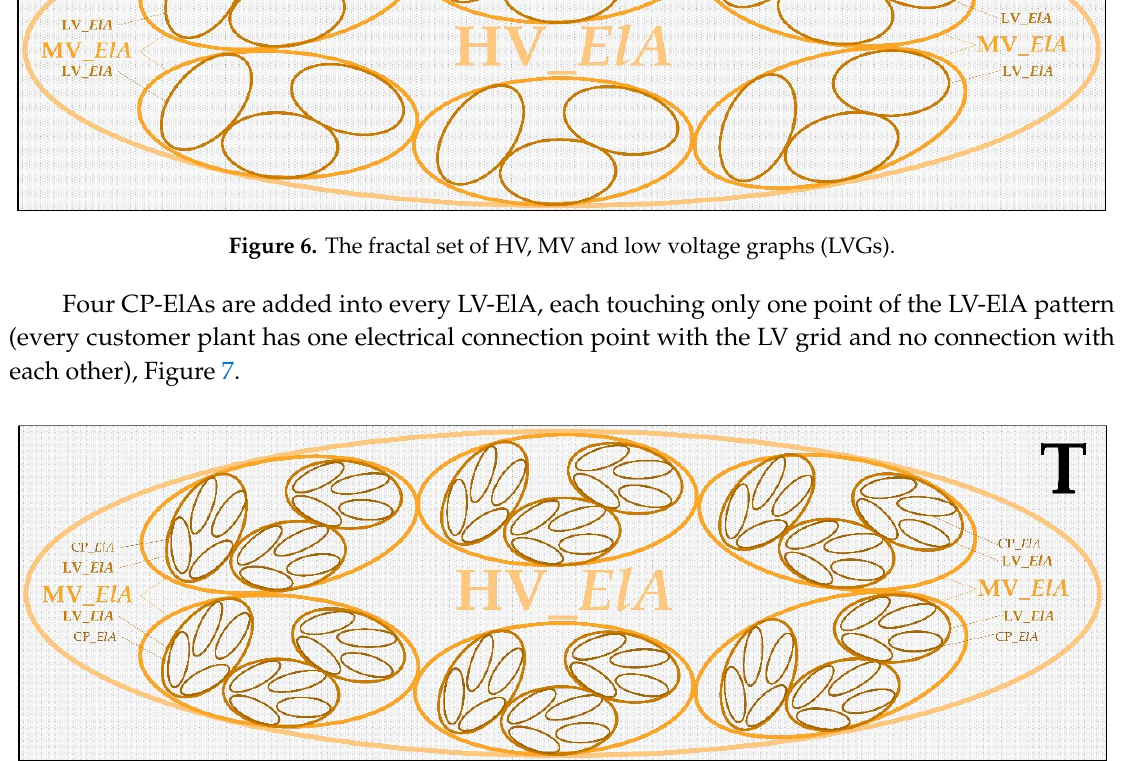
Figure 8. The fractal set of smart grids. The significance of the fractal set of smart grids is verified by the calculation of the fractal dimension. It contains information about the geometrical structure at multiple scales reflecting the complexity of the fractal set: The greater the complexity, the larger the fractal dimension. 3.1.3. Fractal-Dimension Fractals can be characterized by the fractal dimension D . For a fractal located in a bi-dimensional space, D is larger than 1 and less than 2,